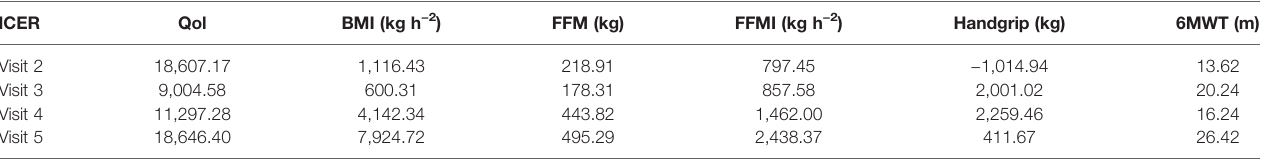
TABLE 3 | Secondary outcomes of cost-effectiveness analyses. ICER